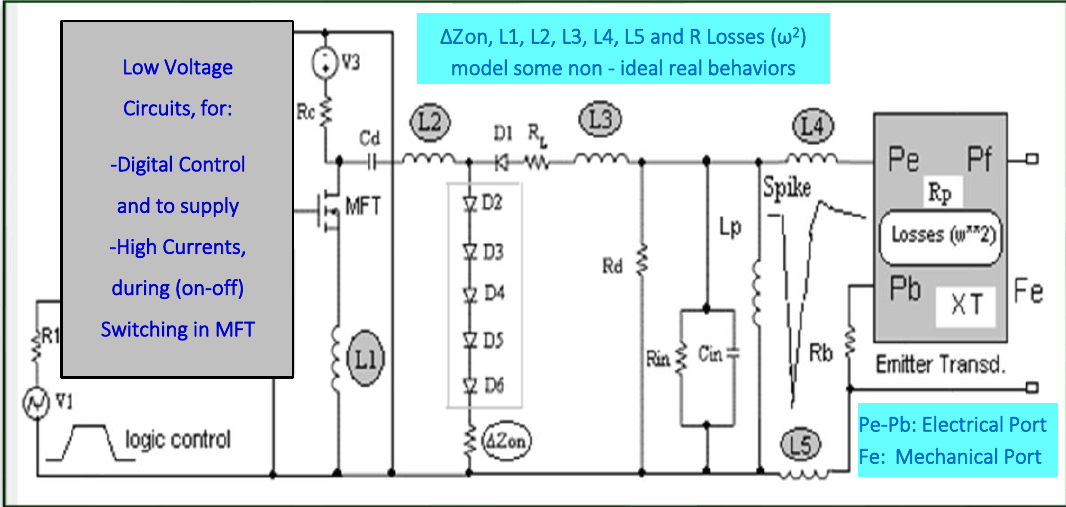
Figure 6. Scheme of our global circuital modeling for emitter responses simulation under high-power capacitive driving in the high-frequency range, with electrical non-ideal behaviors and quadratic piezoelectric losses in